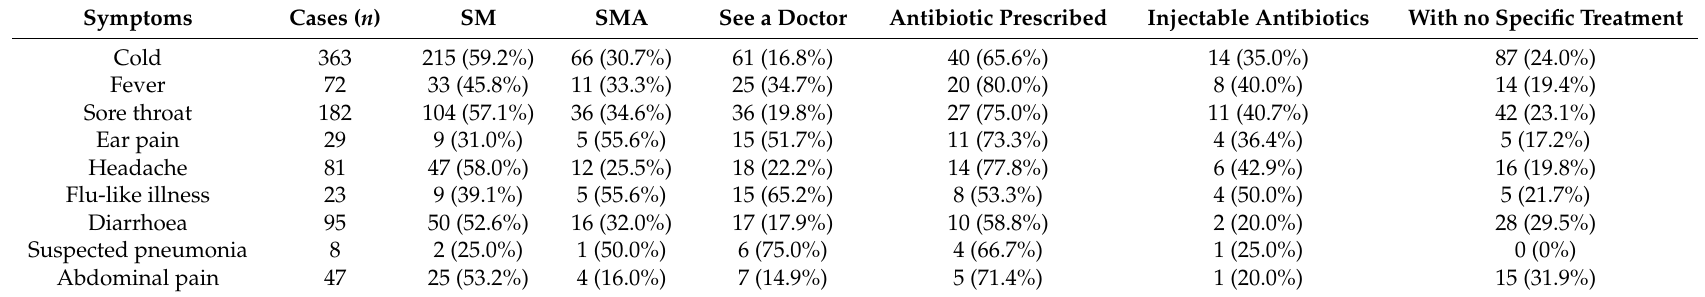
Table 3. Antibiotic use behaviour for self-limiting illness symptoms among medical students in China in 2015 ( n =